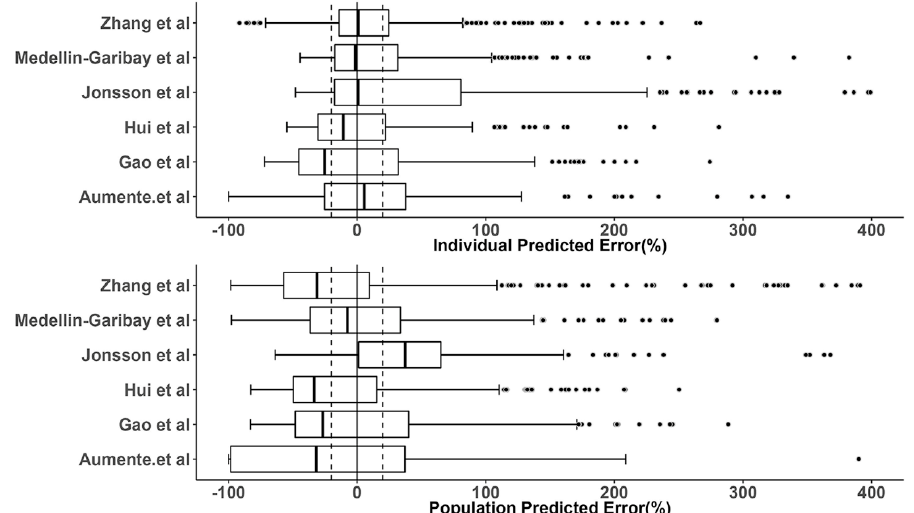
Figure 3. Prediction error (PE) distributions of the individual (upper panel) and population (bottom panel) predictions for evaluated population pharmacokinetic models of methotrexate using an independent dataset in children with acute lymphoid leukemia. In the boxplots, the lower boundary of the box indicates the 25th percentile, the line within the box marks the median, and the upper boundary of the box represents the 75th percentile. Whiskers above and below the box indicate 1.5-fold of the interquartile range below the 25th percentile and above the 75th percentile, respectively. Points above and below the whiskers are defined as outliers. The vertical black solid line represents the PE value at zero (unbiased), and the dashed black lines indicate ±20% of PE (acceptable bias) [11,19–21,26,36].